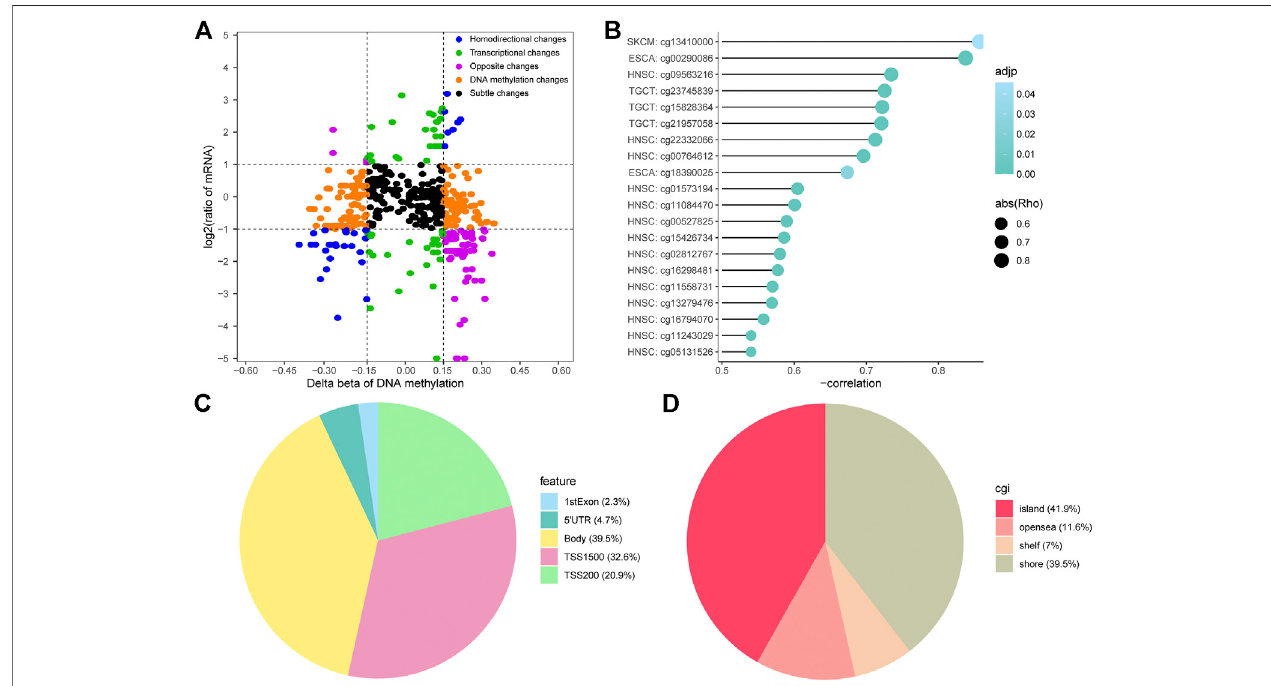
FIGURE 4| Identi fi cation of the methylation-transcription axis in platinum-treated patients. (A) Methylation and transcriptionplots oftranscription-regulativeDMPs and correspondinggenesintheCR/PRgroups. (B) Top 20DMPswith negative correlation coef fi cients intheopposite changefractions. (C – D) Proportionofgenesand CpG islands (CGI) features of transcription-affective